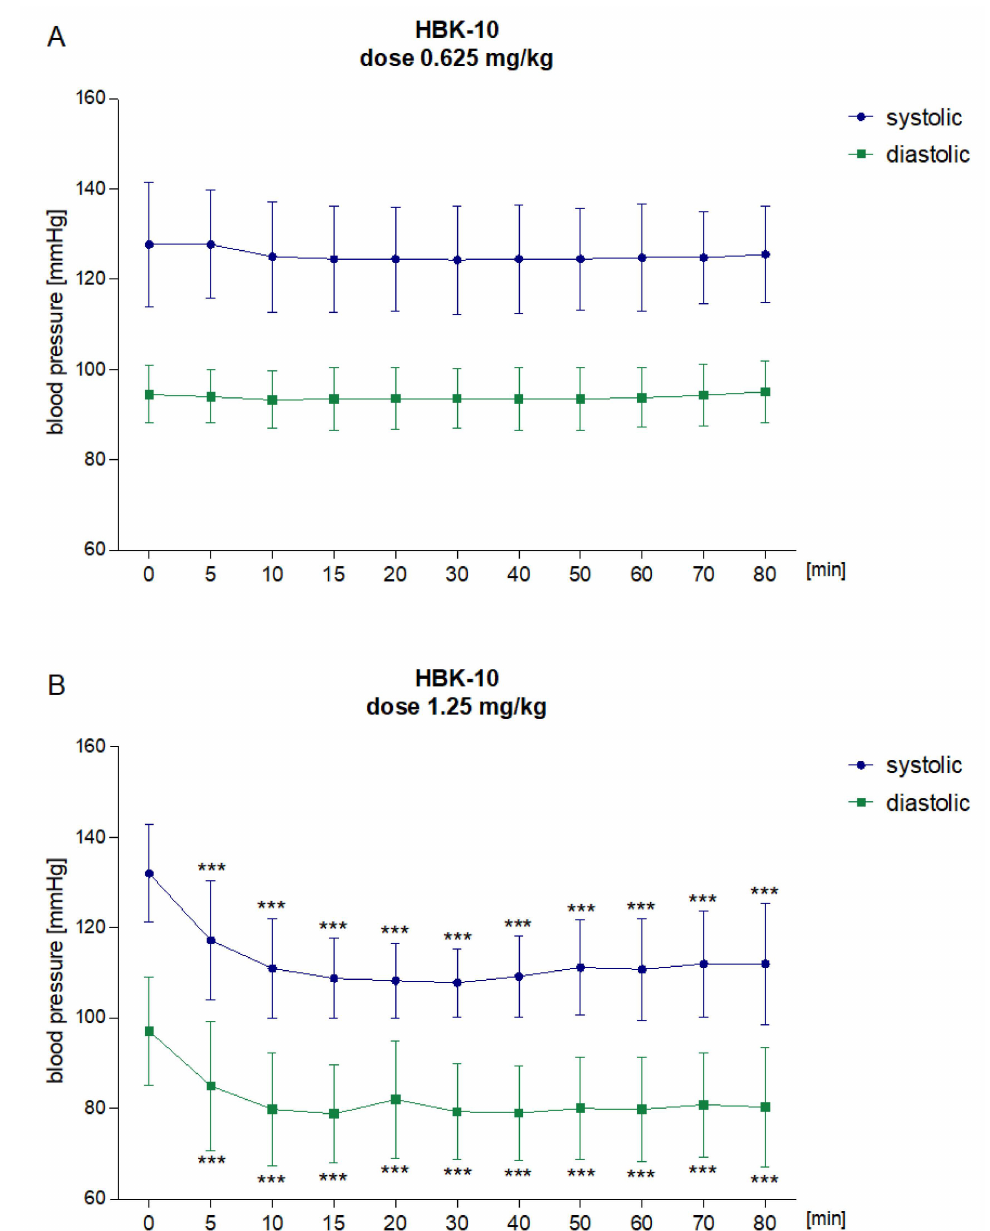
Figure 2. The effect of HBK-10, administered at doses 0.625 (Panel A) and 1.25 mg/kg (Panel B), on the systolic and diastolic blood pressure in normotensive rats. The tested compound was administered intraperitoneally ( ip ) and the blood pressure was measured 5, 10, 15, 20, 30, 40, 50, 60, 70, and 80 min after injection. The results are presented as means ± SD. Statistical analysis: one-way repeated measures ANOVA (Dunnet’s post hoc); *** p < 0.001 vs. blood pressure before the administration of the test compound (time point = 0 min); n = 6